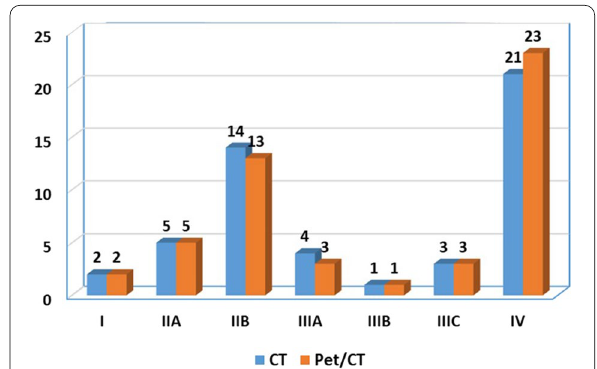
Fig. 7 Comparison between CT and PET/CT according to overall